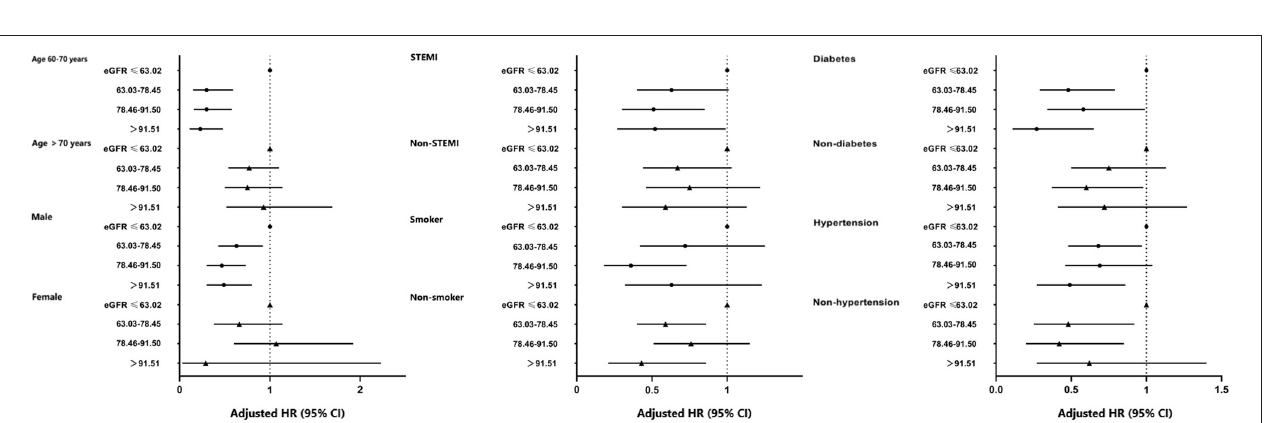
FIGURE 4 | Decision curve analysis. The net benefit of using a “Nomogram” model to predict the 1- year (A) and 3-year (B) event of all-cause death as compared with strategies of “ALL” (assume all patients will have death for any reason), or “None” (assume death for any reason occurred in no patients) for different thresholds.